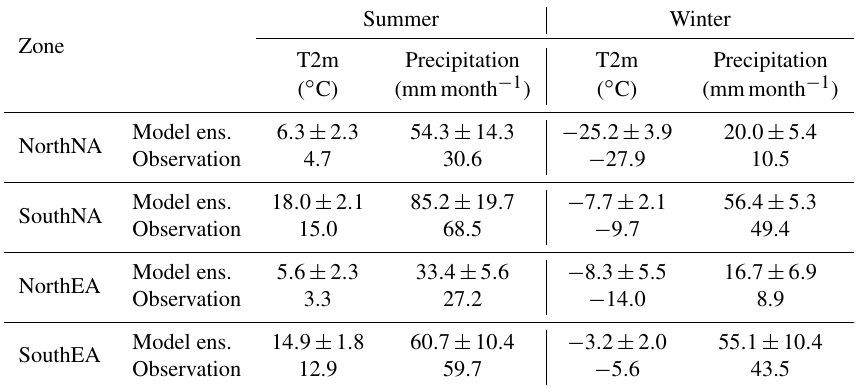
Table 3. The sieved sub-ensemble and observed mean summer and winter 2m temperature and precipitation averaged over four latitudinal bands for the 1950–1980CE